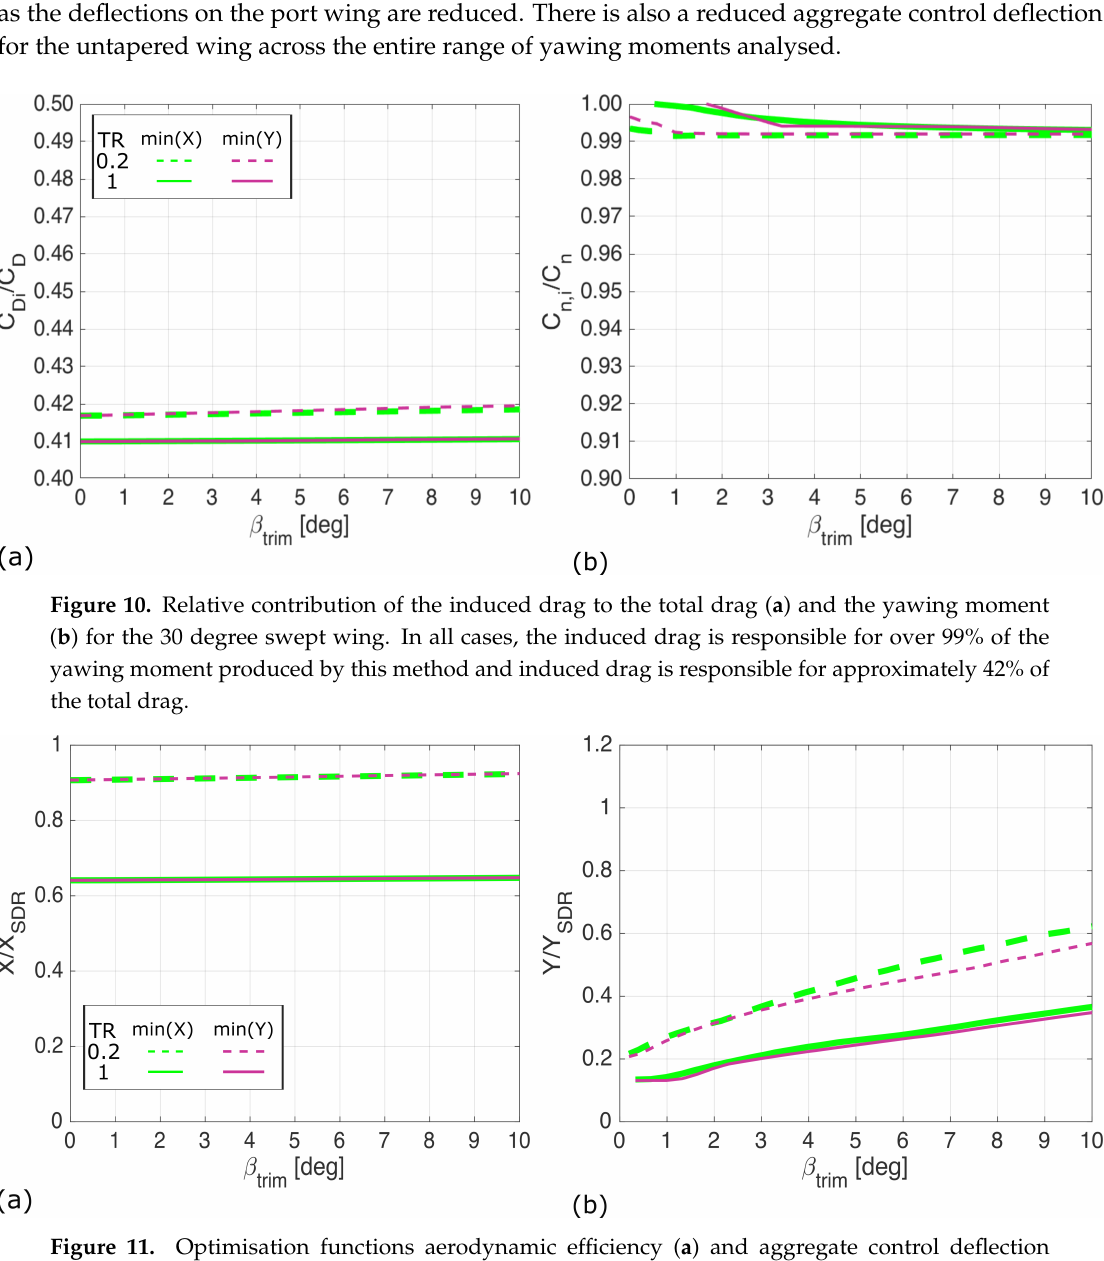
Figure 11. Optimisation functions aerodynamic efficiency ( a ) and aggregate control deflection ( b ) objectives for a 30 degree swept wing normalised by the same metrics for a SDR. Variations are shown up to a given sideslip trim angle of 10